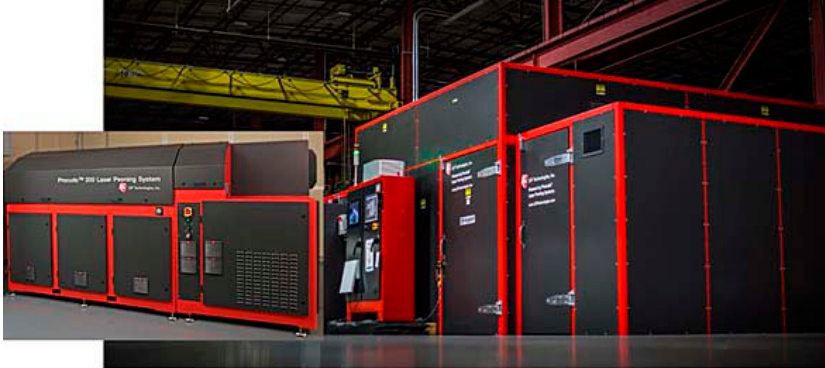
Figure 20. The next generation laser peening laser, the Procudo Laser Peening System by LSP Technologies, Inc.